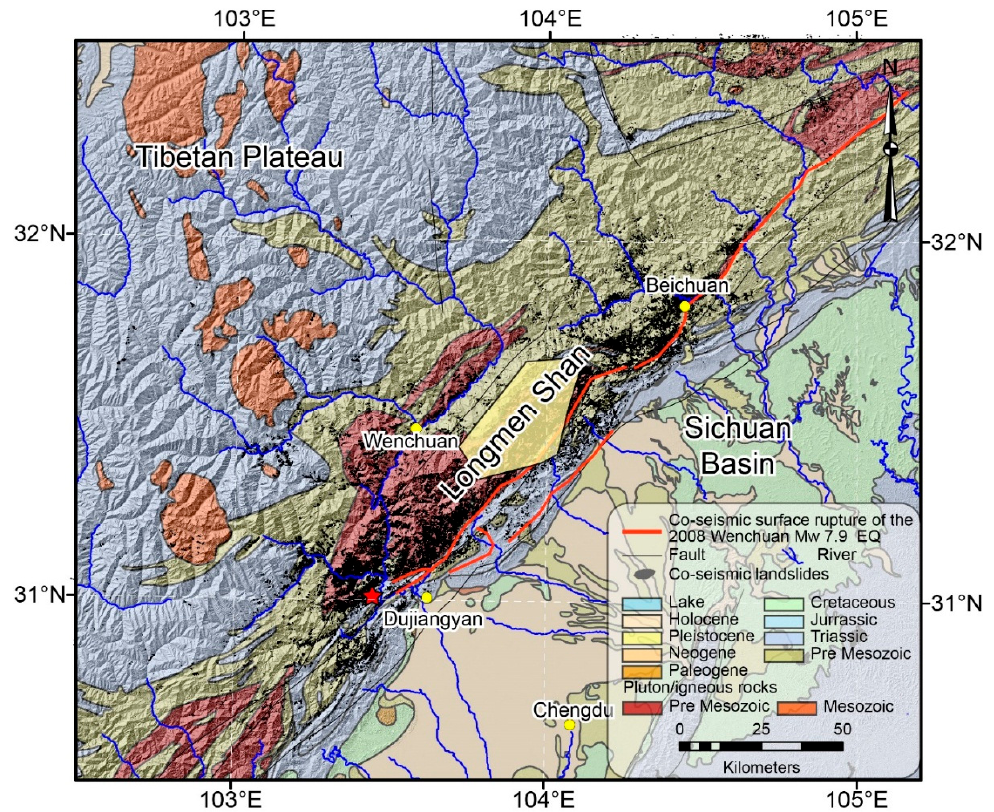
Figure 1. Simplified geological structures of the Longmen Shan region. Thick red lines indicate the co-seismic surface ruptures of the 2008 Mw 7.9 Wenchuan earthquake [16–18]. The gray polygons indicate the landslide inventory (courtesy of Joshua West and Gen Li), and the yellow polygon indicates the area covered by the high-resolution DEM.